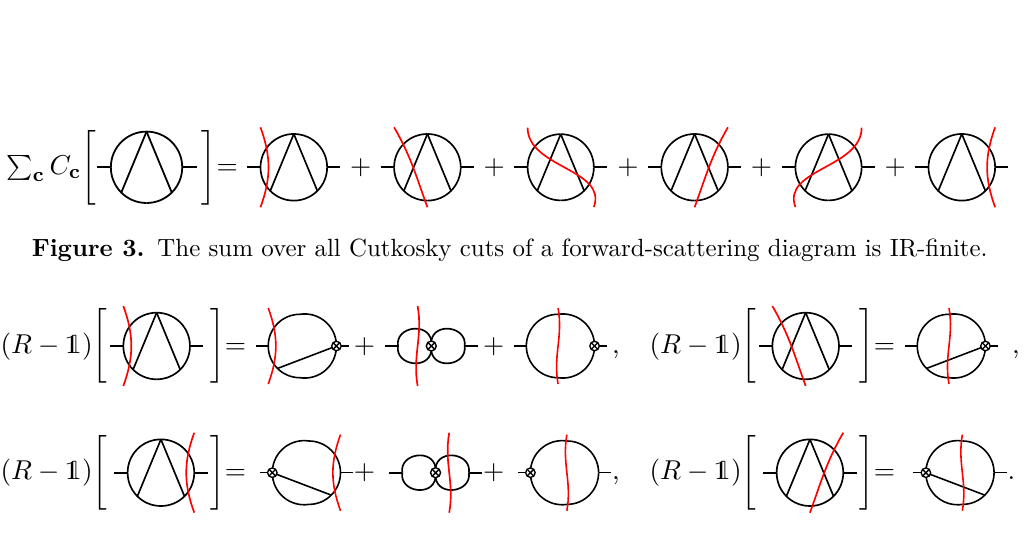
Figure 4. The R -operation can be appropriately defined so as to act on interference